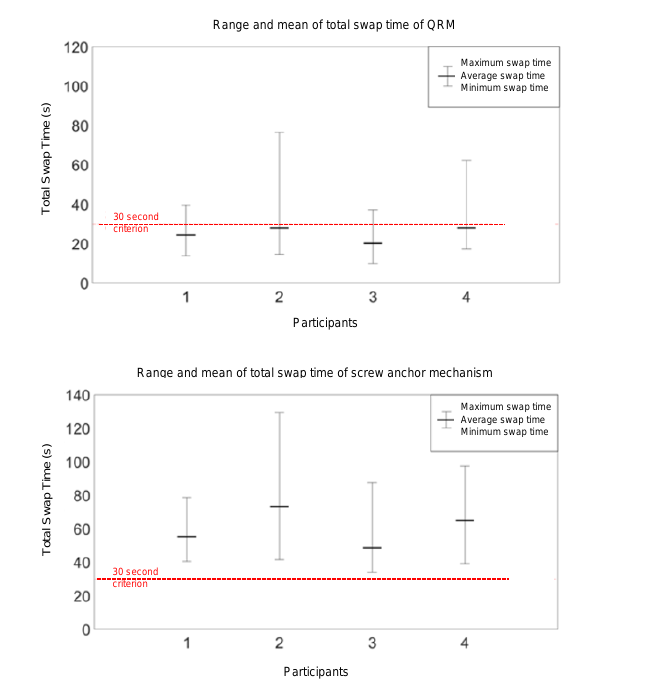
Figure 6: Range and mean of total swap time for QRM and screw anchor